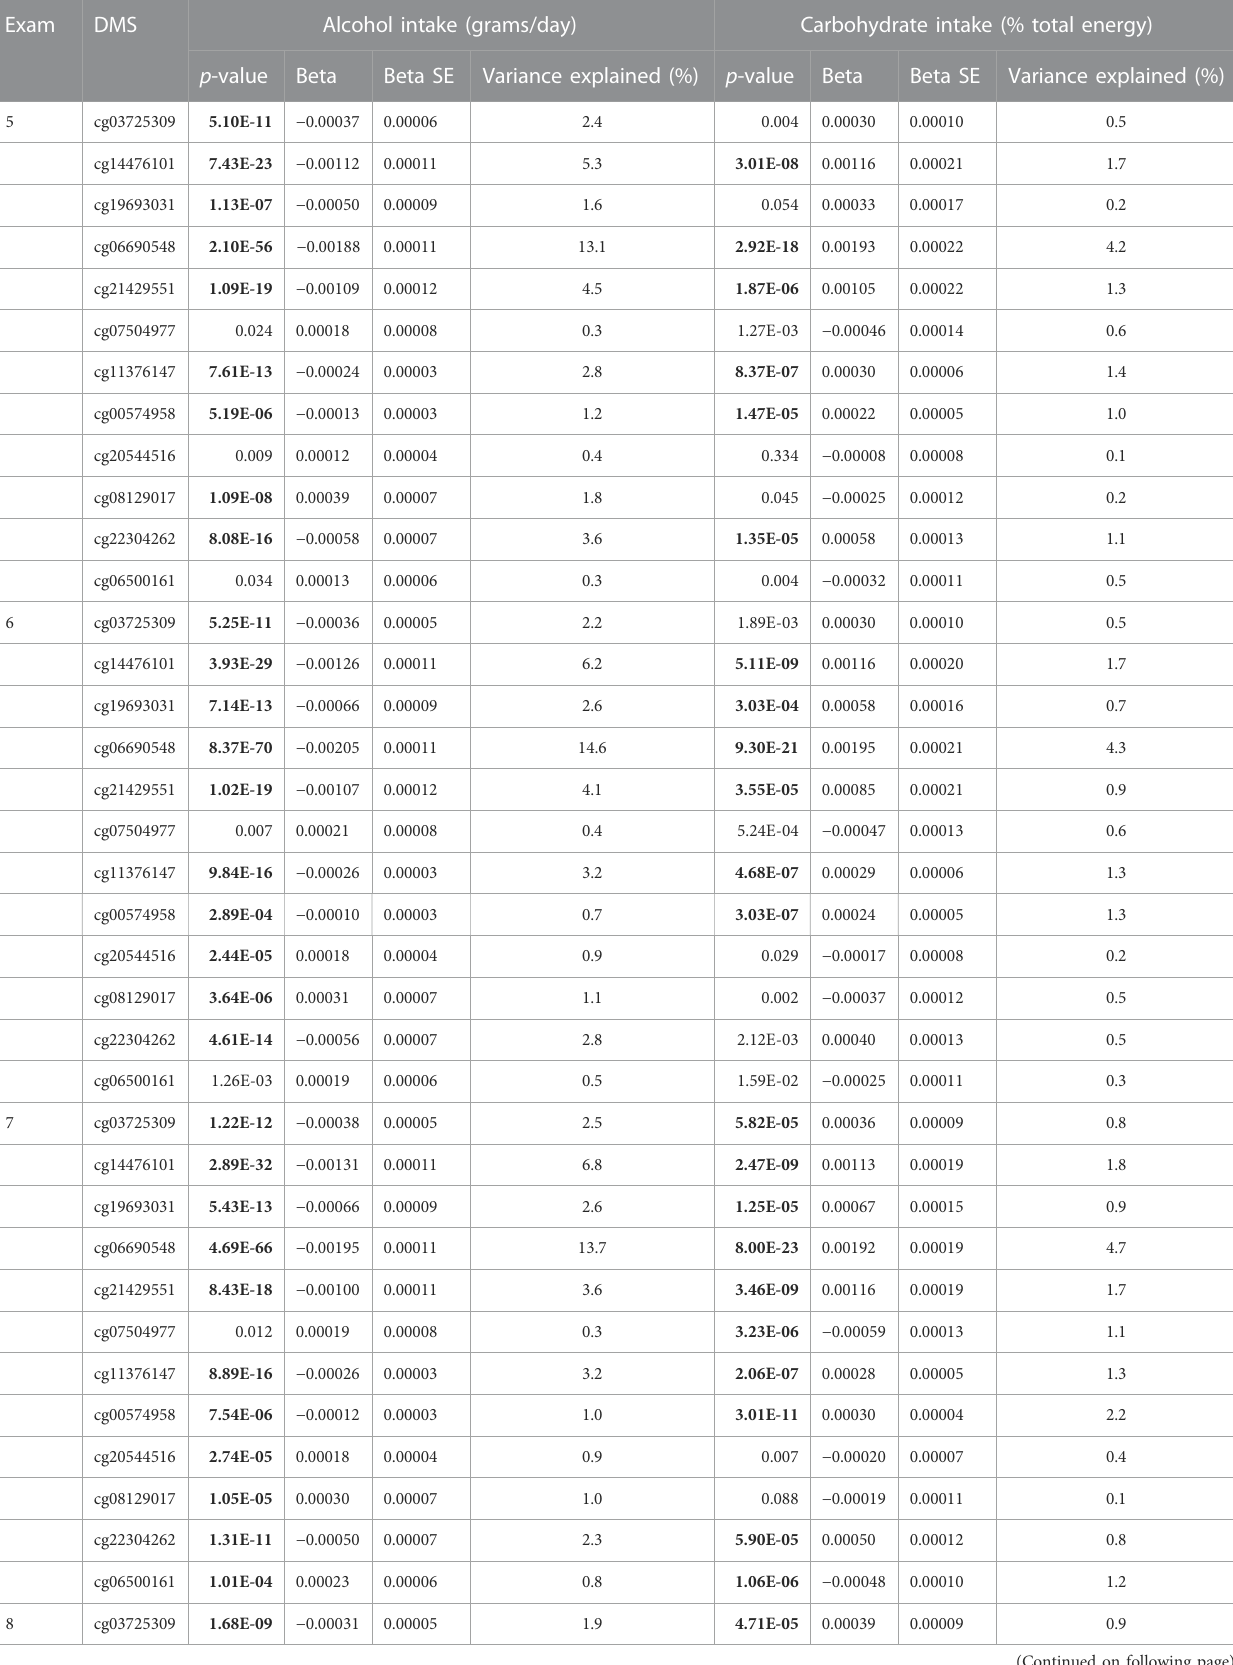
TABLE 3 12 Epigenetic variants associated with alcohol consumption or/and carbohydrate intake across four exams in